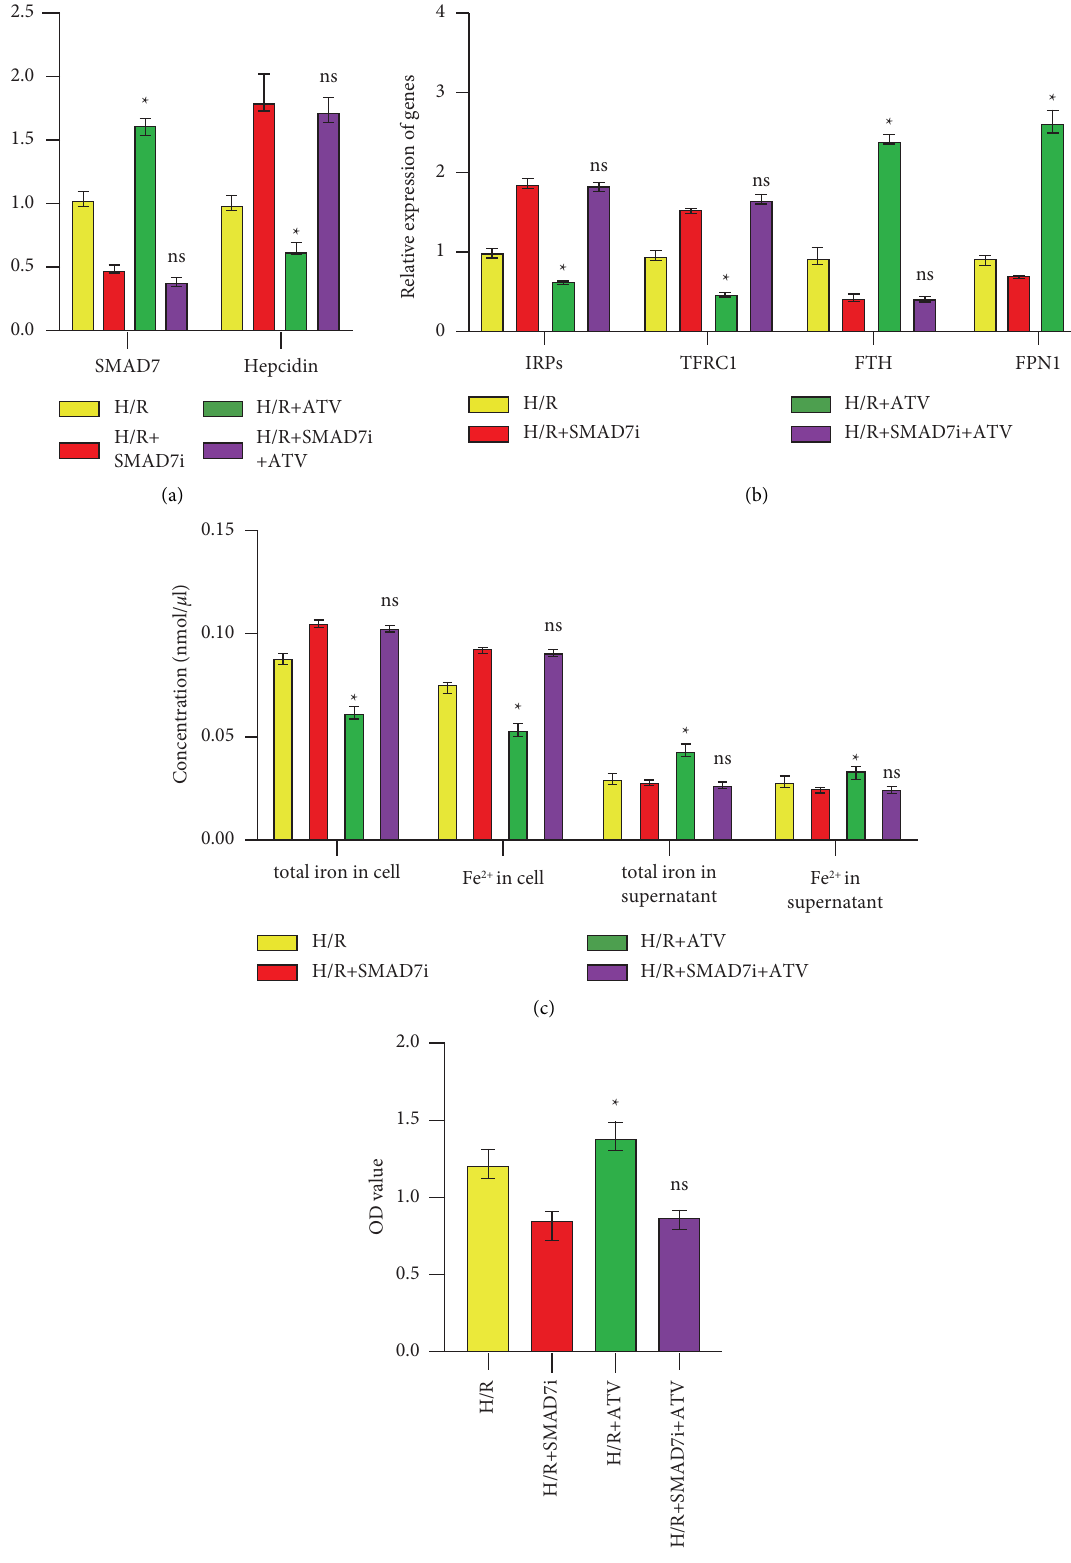
Figure 4: ATV inhibited ferroptosis in H9C2 cells through the SMAD7/hepcidin pathway. (a–b).Te relative expression of SMAD7, hepcidin, IRPs, TFRC1, FTH, and FPN1 were detected by qPCR. (c). ELISA was utilized to determine the concentration of total iron and Fe 2+ . (d). Te cell vitality was measured by CCK8. ∗ P < 0 . 05 vs. the H/R group. ns: no signifcant diference vs. the H/ R +SMAD7i